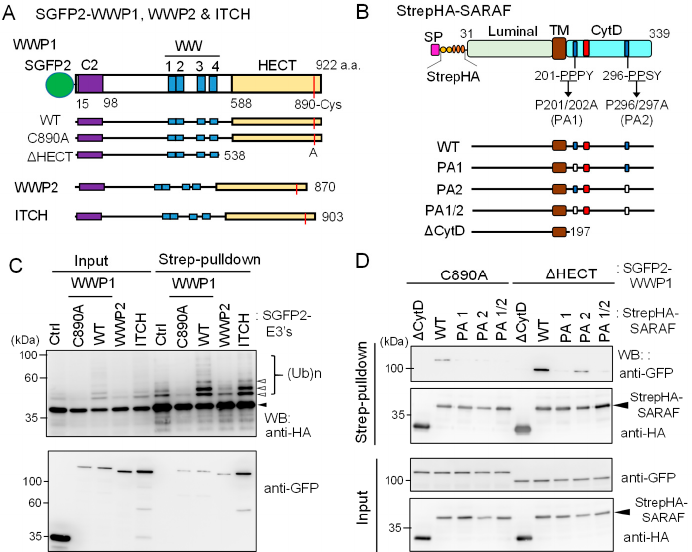
Figure 7. Ubiquitination of SARAF by WWP1 ubiquitin E3 ligase. ( A ) Schematic diagrams of SGFP2 ‐